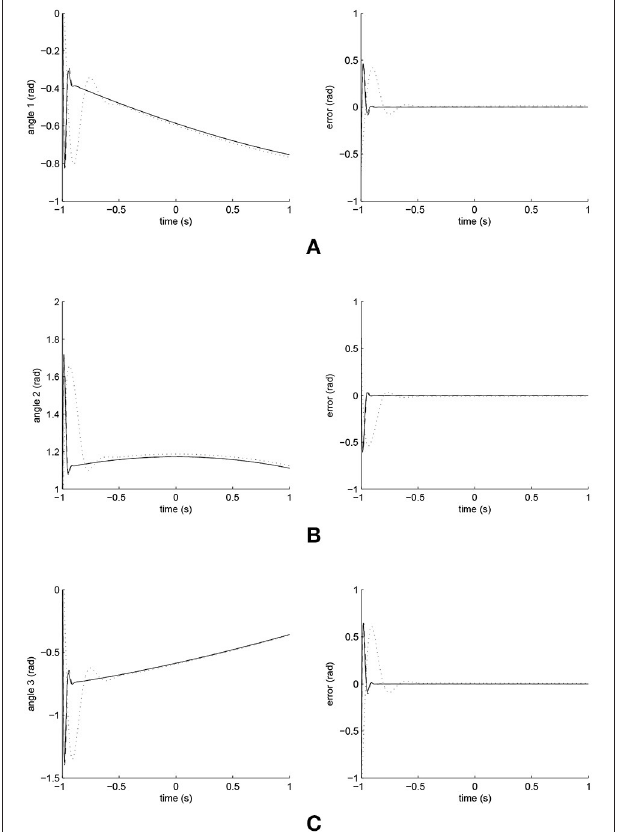
FIGURE 9 | Trajectory responses (in the left) and tracking errors (in the right) of Joints 1, 2, and 3 at ρ 2 = 1. The solid line indicates the performance of the iFBEL; the dotted line represents that of the PID controller; and the dot dash line implies that of the FCMAC controller. (A) Trajectory response and tracking error of Joint 1. (B) Trajectory response and tracking error of Joint 2. (C) Trajectory response and tracking error of Joint 3.